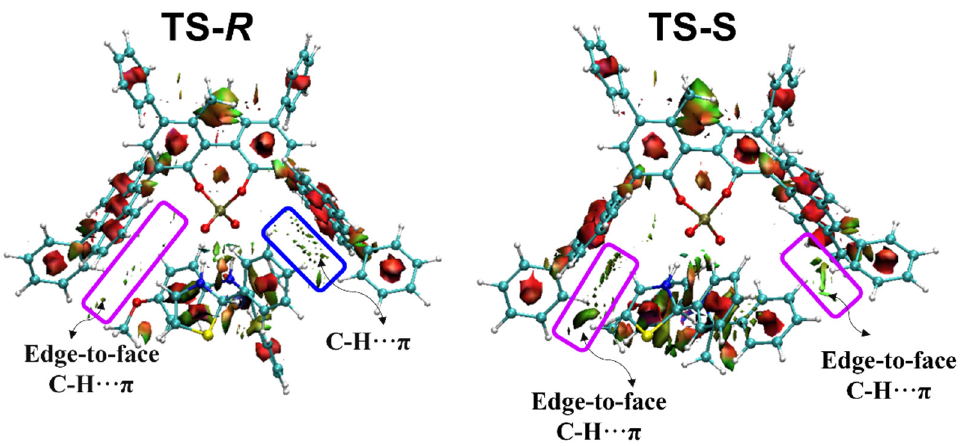
Figure 4. NCI analysis of TSs within − OCH 3 substituted (blue, strong attraction; green, weak inter- action; red, strong repulsion). The pink and blue cycles represent the steric effects due to edge-to- face C-H··· π and C-H··· π interactions,